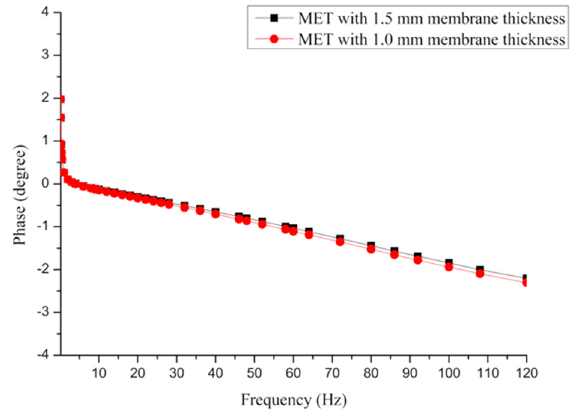
Figure 11. Frequency vs. phase of the MET that is equipped with different membrane thicknesses.